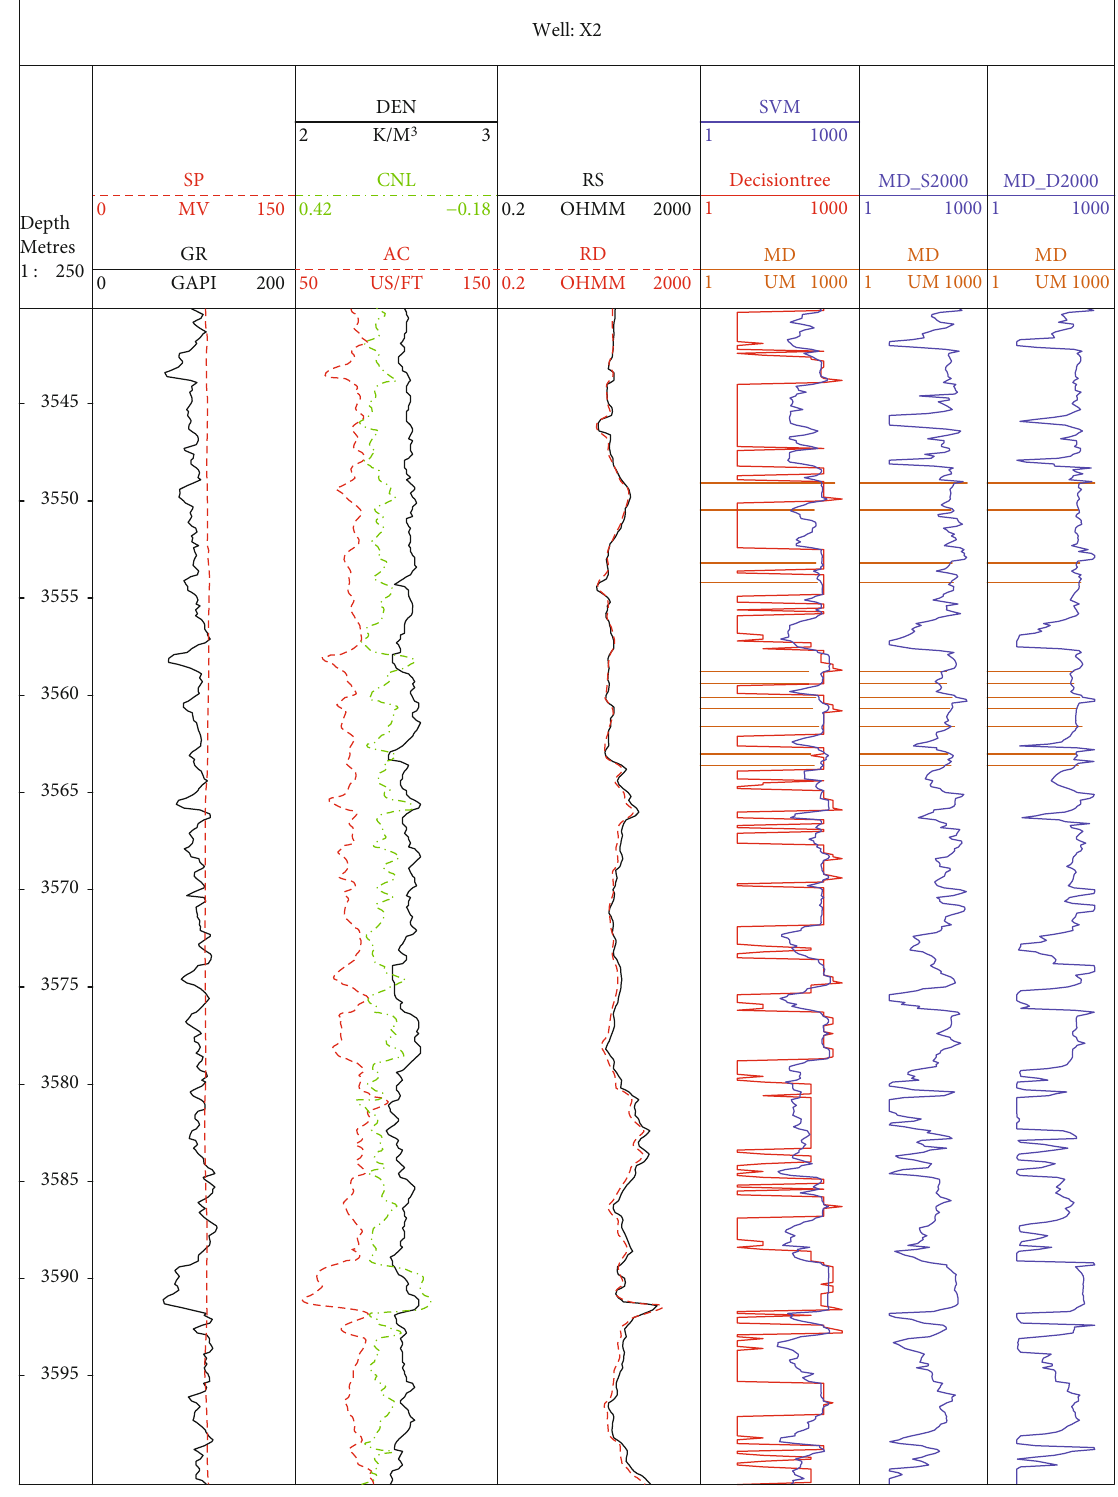
Figure 16: The results of the prediction of the median rock grain size of the conventional logging data in the S